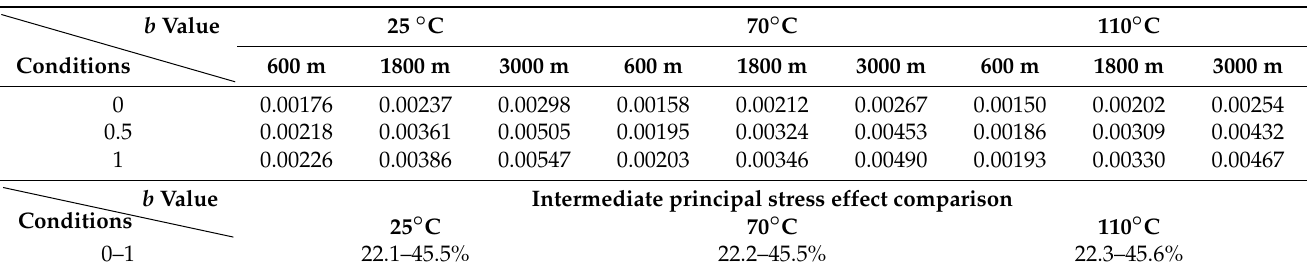
Table 5. The critical collapse major principal strain with the same temperature under different wellbore depths and different b